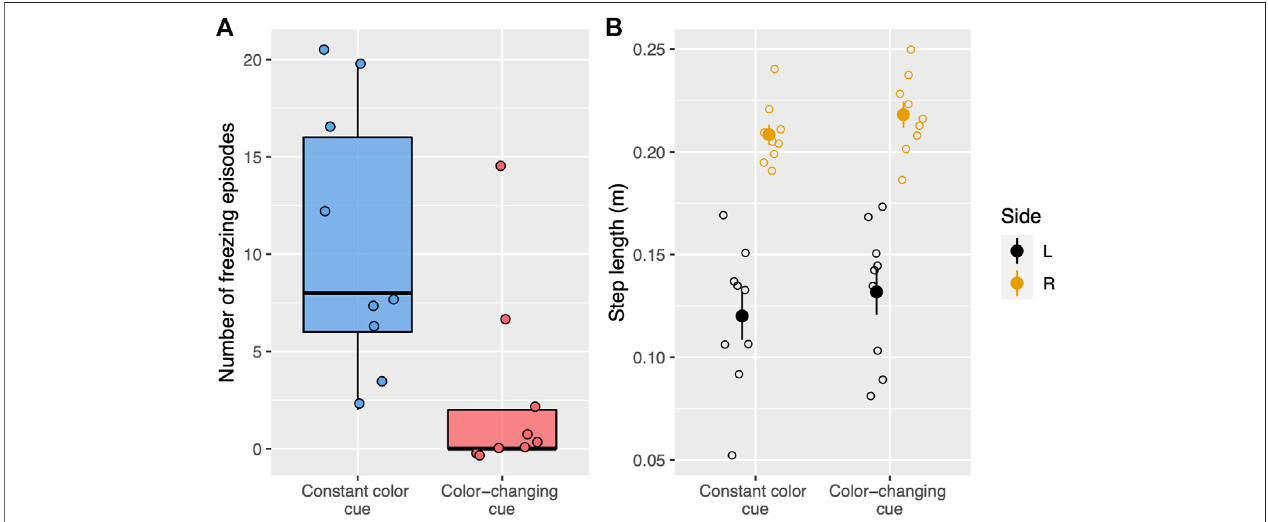
FIGURE 4 | (A) Boxplots show the number of freezing episodes during treadmill walking for two types of visual cues. Each dot represents a single trial. Trials with constant color cues are blue whereas trials with color-changing cues (stepping stones change color) are red. (B) Step length for each side and visual cue condition (constant color, color-changing) during treadmill walking. Each open circle represents the average step length for a single trial. The fi lled circle represents the average step length for each cueing condition and each side and the vertical lines represent standard error. The right side is yellow whereas the left side is